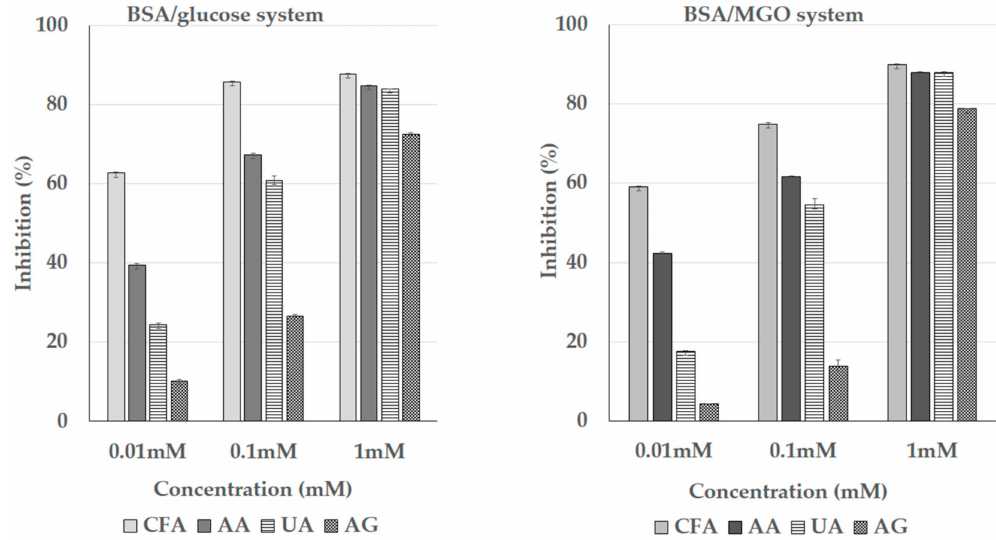
Figure 5. The concentration-dependent inhibitory effects of caffeic acid (CFA), ascorbic acid (AA), uric acid (UA), and aminoguanidine (AG) against advanced glycation end product (AGE) formation as measured in bovine serum albumin (BSA)/glucose and BSA/methylglyoxal (MGO) assays.